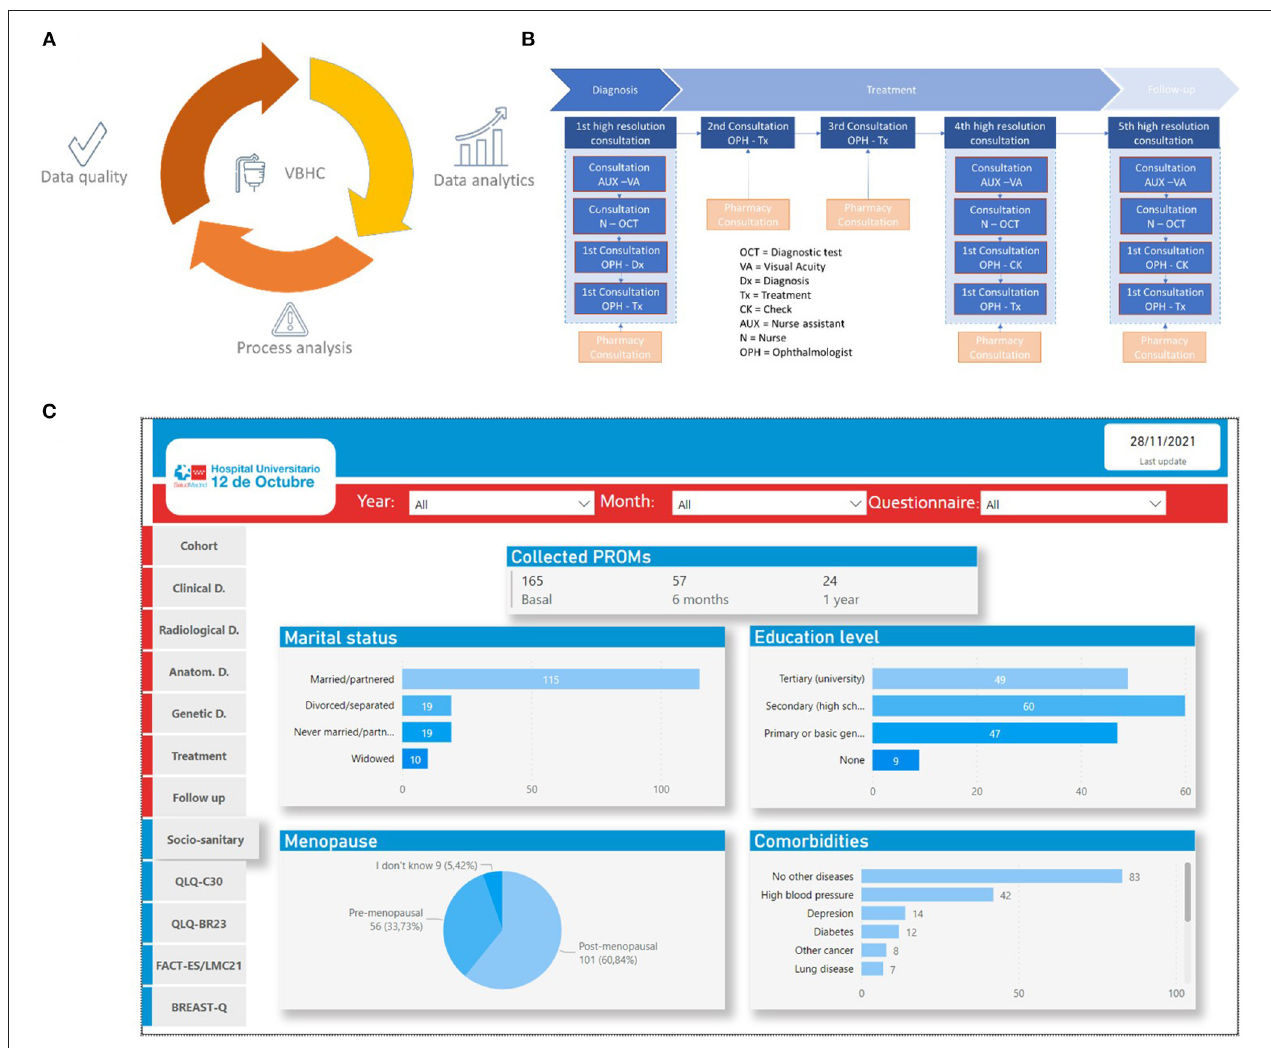
FIGURE 1 | (A) Value-based healthcare (VBHC) requires good data quality, deep knowledge of the medical condition process, and meaningful data analysis. Data recording tools have to ensure easy data recording, appropriate data quality, and confidentiality of the information. The clinical process analysis will help identify how to adapt tools and ensure appropriate quality and safety of the process and data, defining the primary source for each variable measured, the moment to record it, and how this is done within the medical condition process. The epidemiological analysis tools should grant “real-time” methods and quick feedback to the patient care team. (B) Example of ADMD clinical process analysis; (C) Example of the dashboard from the breast cancer